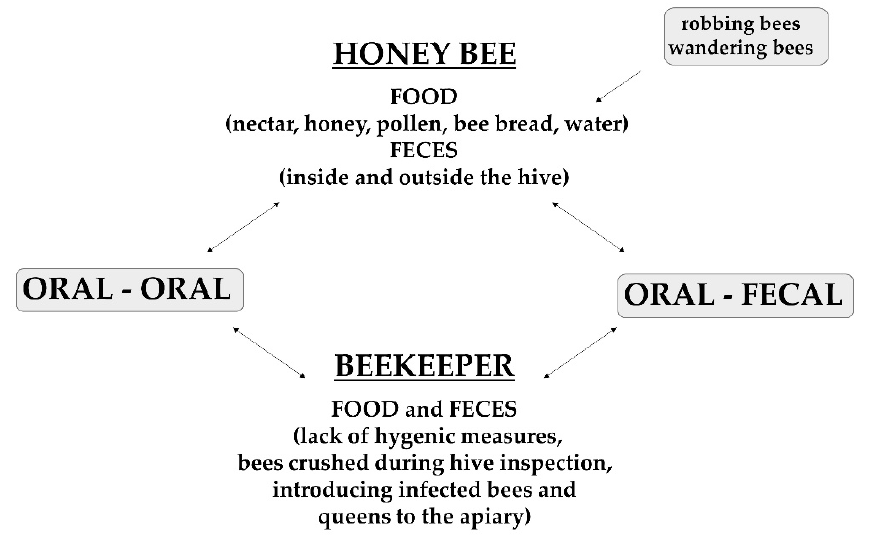
Figure 1. Routes of Nosema spp. infection and spread.